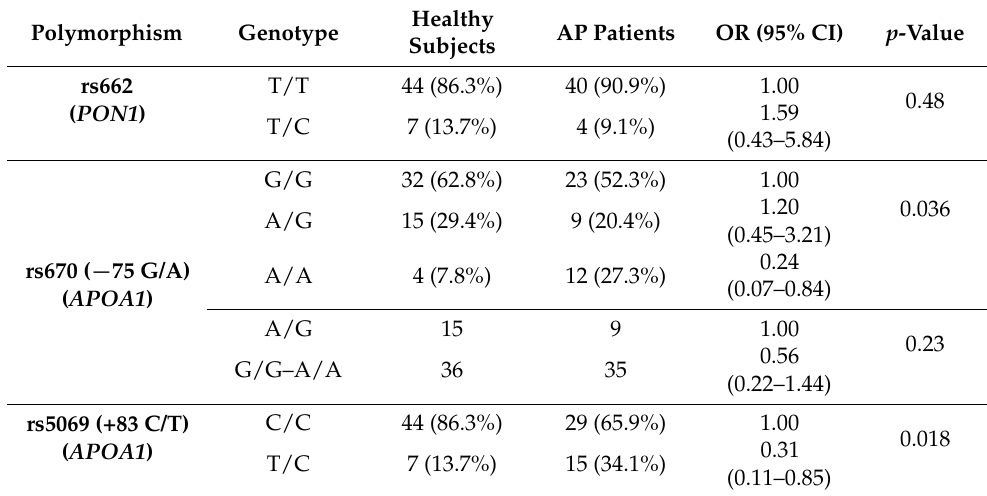
Table 3. The frequency of genotypes for SNP rs662 in the PON1 gene and SNP − 75 bp and +83 bp in the APOA1 gene in the group of patients with acute pancreatitis and healthy